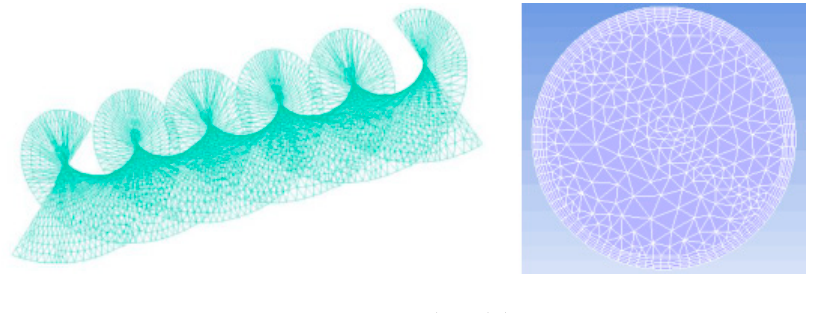
Figure 3. Grid model.